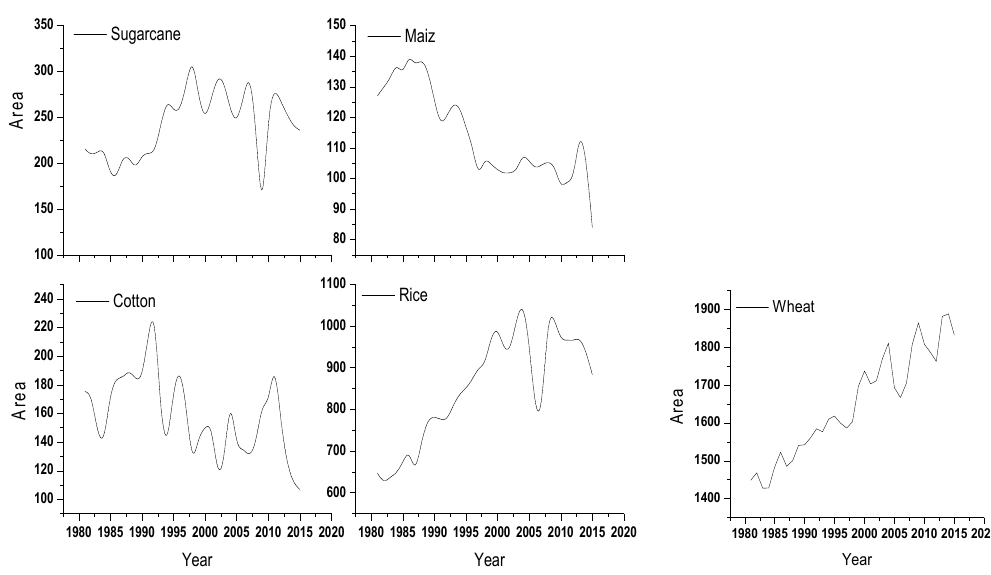
Figure 2. Long-term changes in crop sown area (CSA) (1000 hectare) of five major agricultural crops grown in Rechna Doab from 1981–2015. Table 2. Multi crop information parameters used in the CROPWAT model to compute Crop Irrigation Requirement (CIR) of five major crops grown in Rechna Doab.